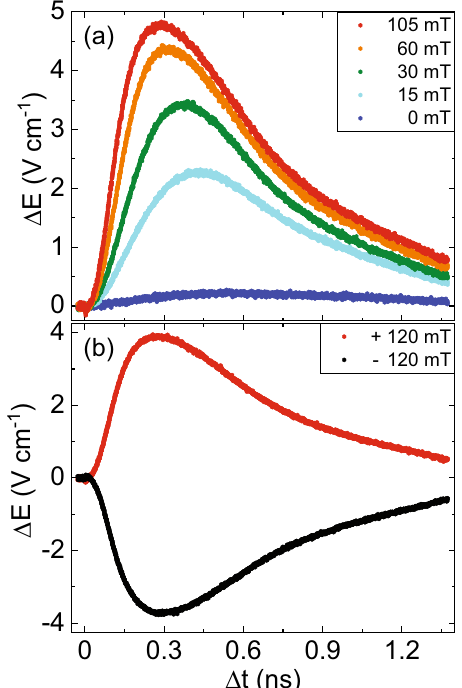
Fig. 3 Dynamics of the double-pump THz emission Δ E measured at 300 K. a The Δ E signal for various external magnetic fi eld strengths and H ¼ 120 mT. b for two opposite polarities at μ 0